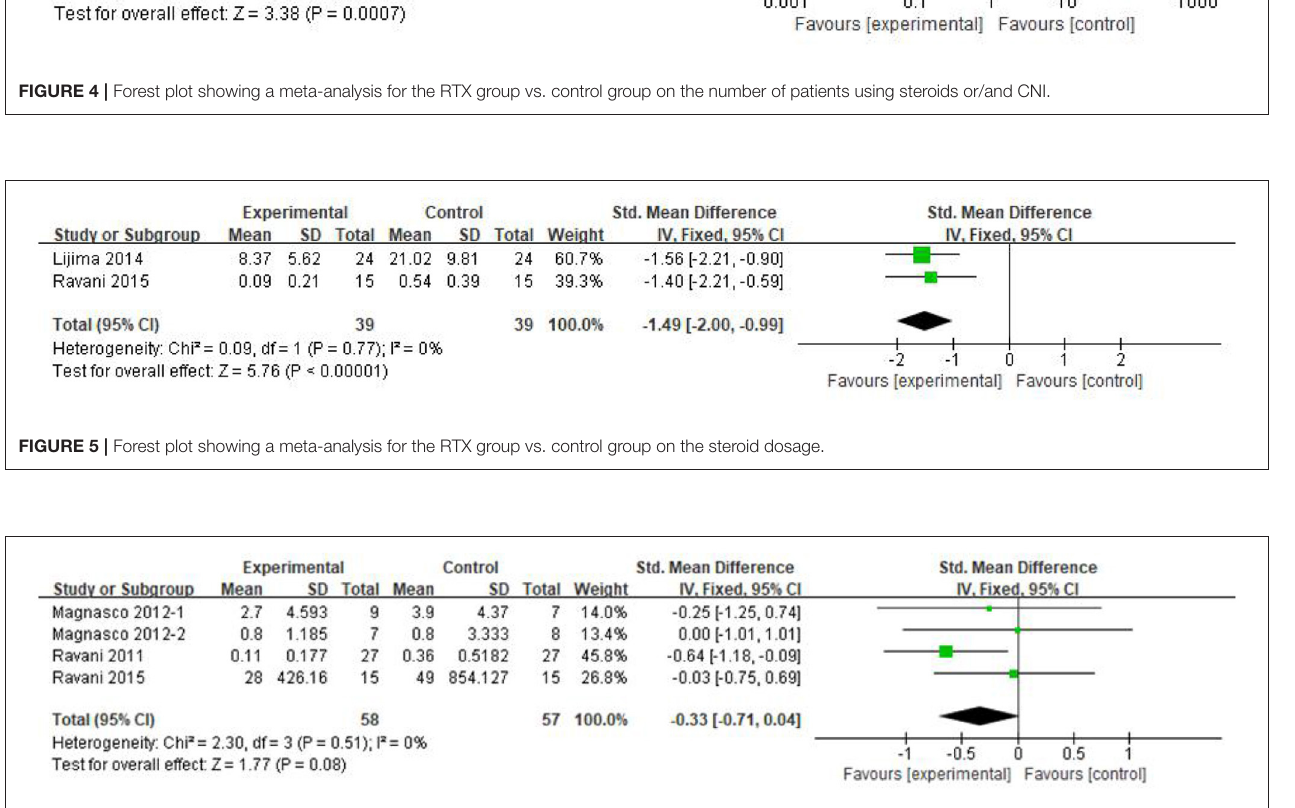
Frontiers in Pediatrics | www.frontiersin.org